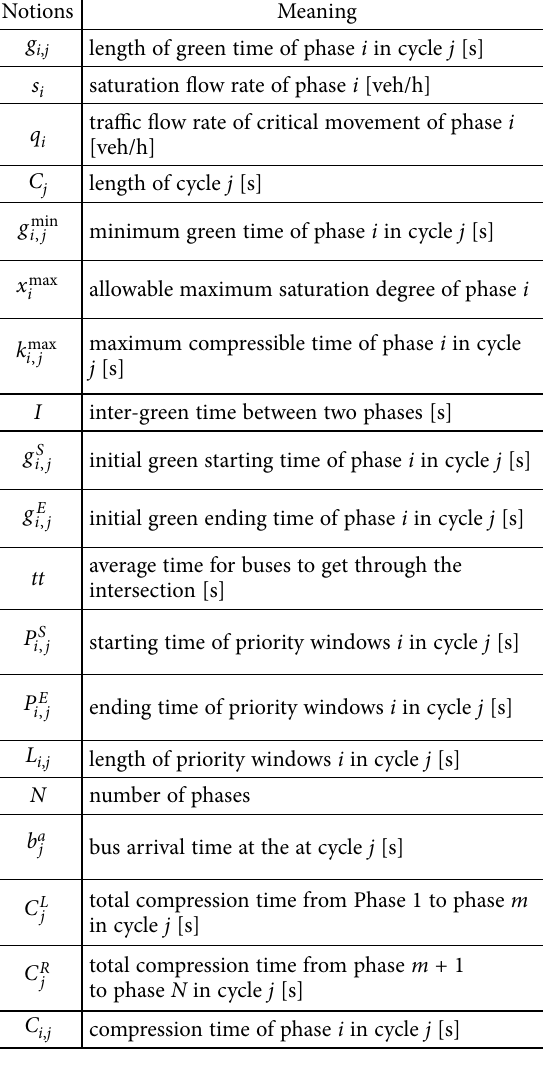
Table 1. Summary of parameters